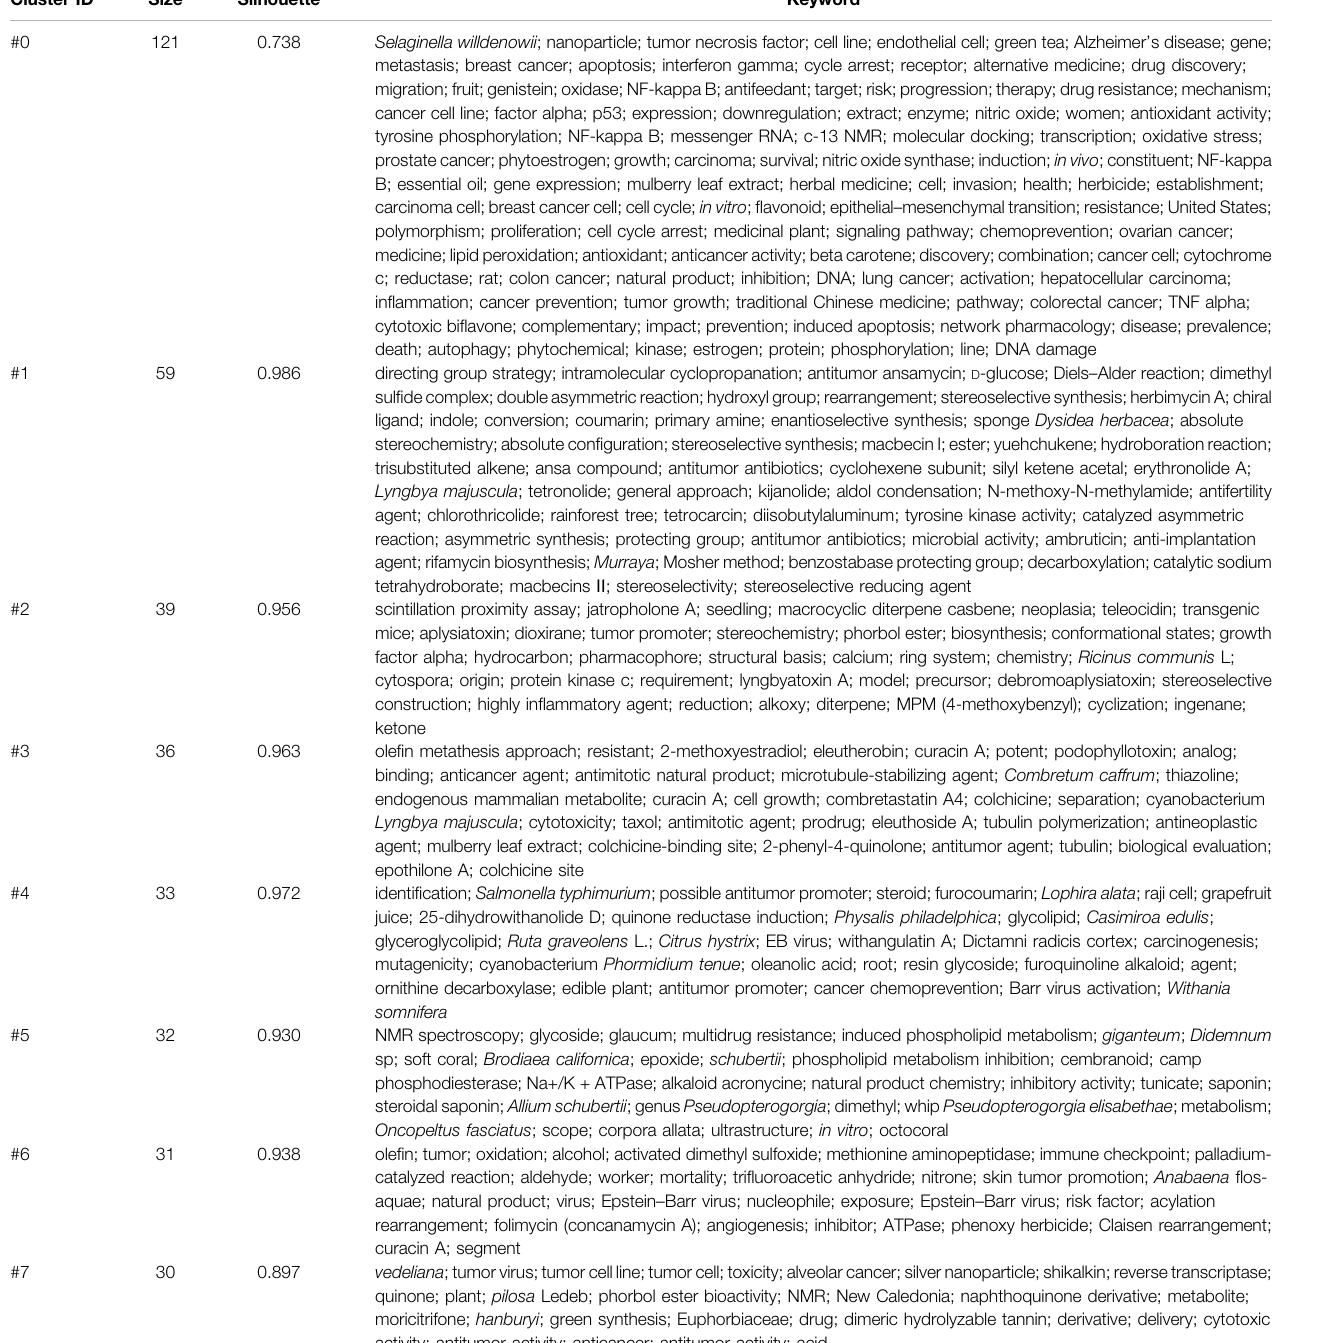
TABLE 6 | Detailed list of keyword clustering networks in scienti fi c articles on anticancer natural products. Cluster ID Size Silhouette